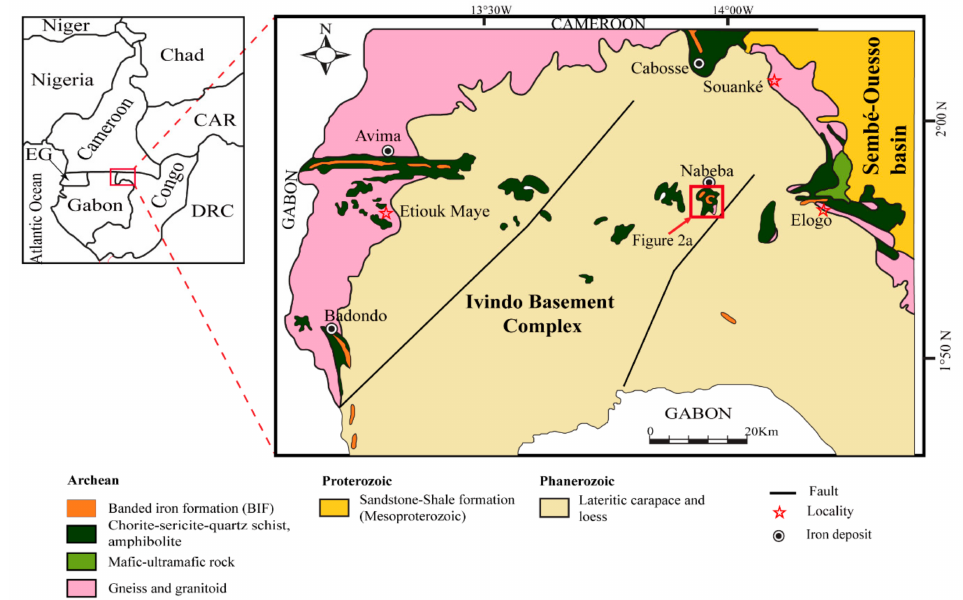
Figure 1. Geological setting of the northwestern Republic of the Congo (modified from [19]). Inset map: Sketched map showing the national border in Central Africa. Abbreviations: CAR, Central African Republic; DRC, Democratic Republic of the Congo; EG, Equatorial